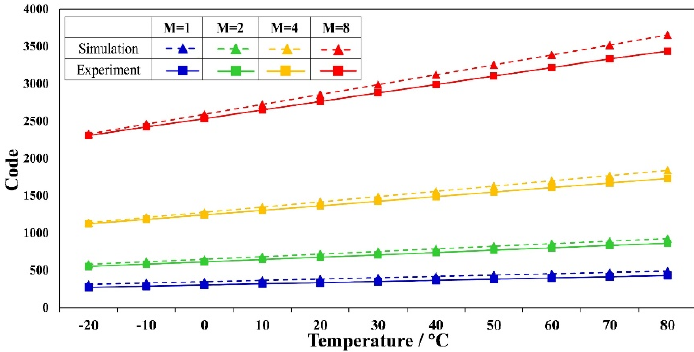
Figure 17. Simulated and measured output for M = 1, 2, 4, and 8.